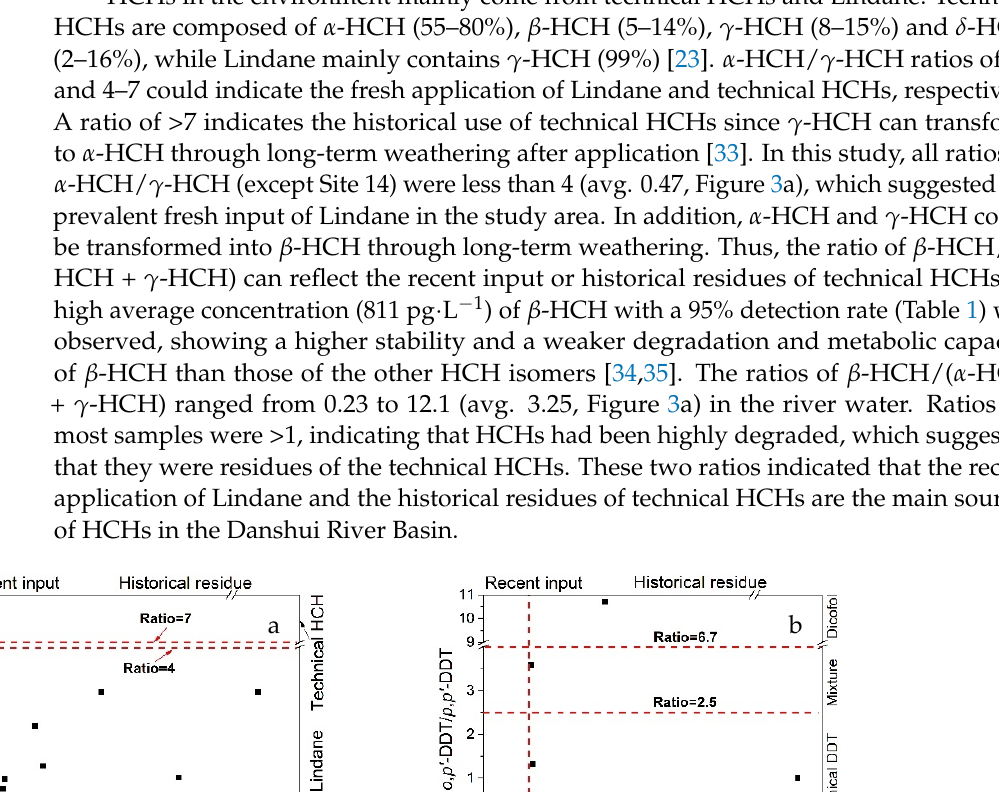
Figure 3. Ratios of HCHs ( a ), DDTs ( b ), chlordane ( c ) and endosulfan ( d ) in the Danshui River.